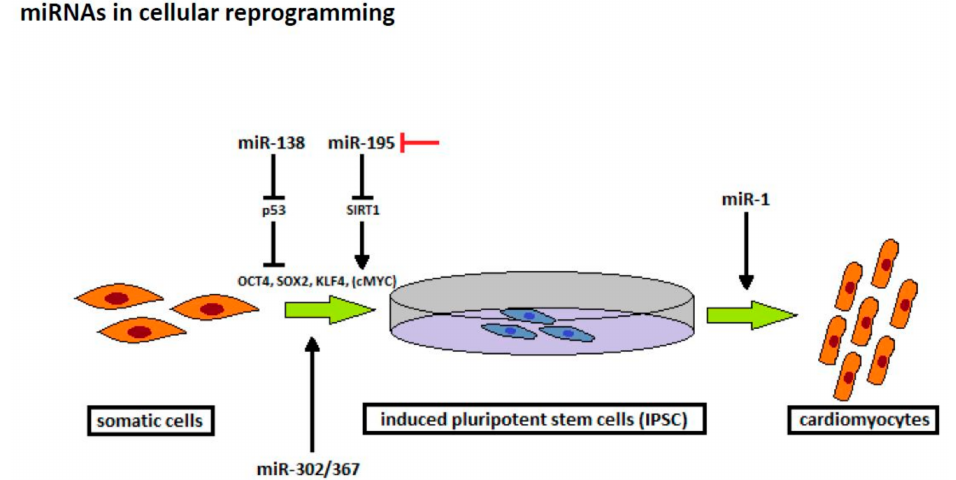
Figure 3. Novel strategies to improve the process of cellular reprogramming deferring from initial transcription